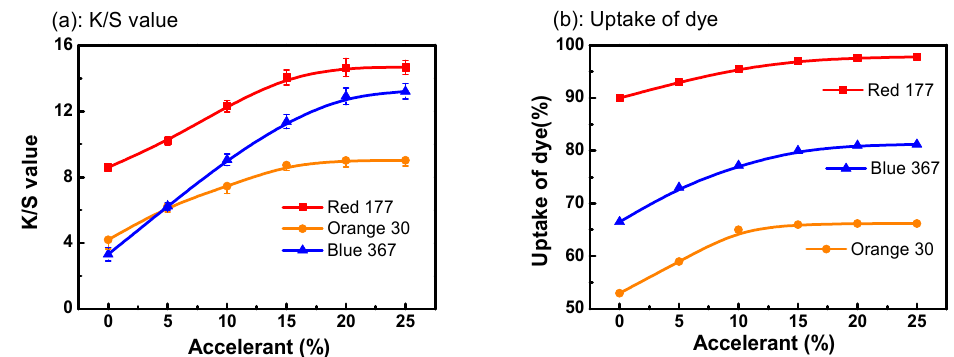
Figure 3. Disperse dying with different amount of accelerant in D5 solvent dyeing system: ( a ) the K/S value of dyed fiber; ( b ) the uptake of dye.